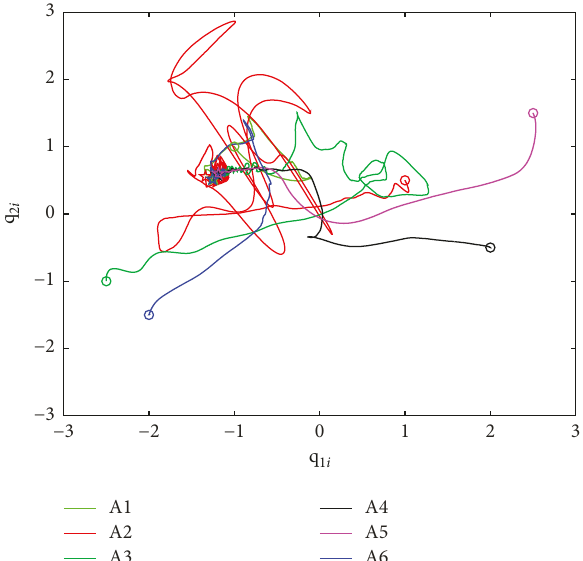
Figure 10: Multiagent trajectories and the fault case (AFSC).